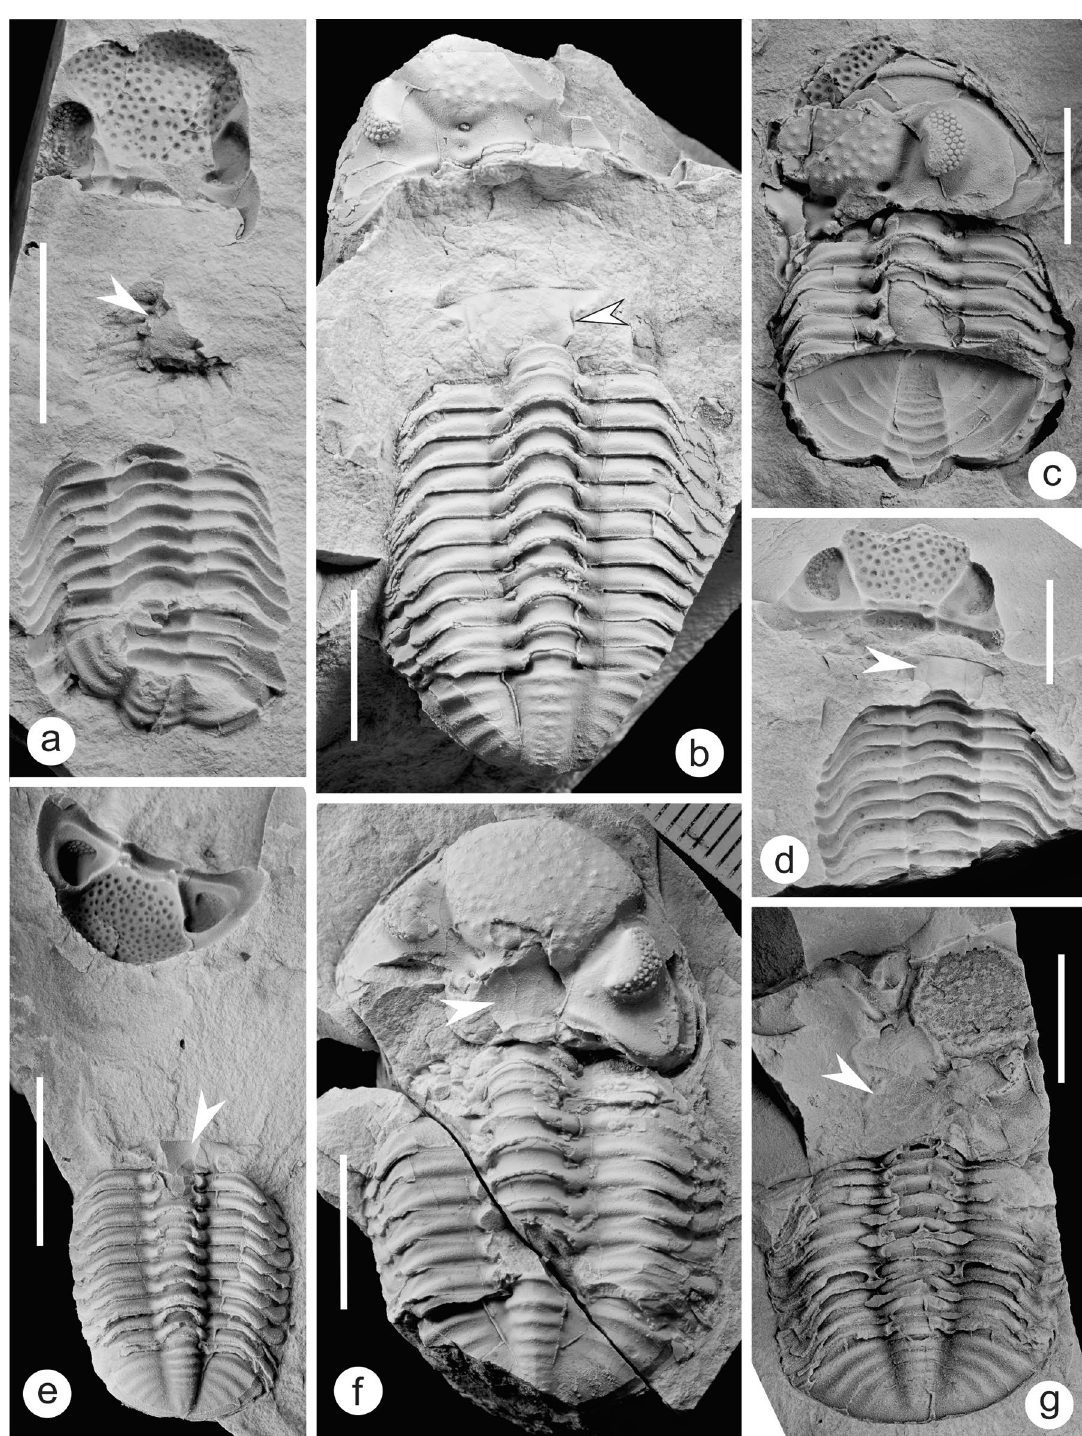
Figure 2. Different types of exuviae of Omegops sp. A from the middle part of the MHF in western Junggar. ( a ) Enrolled thoracopygon with separated cephalon, external mold (BGEG-WJ18-02). ( b ) Flat extended thoracopygon with separated cephalon (BGEG-WJ18-03). ( c ) Separated cephalon overlapping enrolled thoracopygon (BGEG-WJ18-05). ( d ) Cephalon separated from thorax, pygidium is not preserved, external mold (BGEG-WJ18-01). ( e ) Flat extended thoracopygon, with separated inverted cephalon (BGEG-WJ18-06). ( f ) Cephalon separated from thoracopygon and rotated at a small angle (BGEG-WJ18-04). ( g ) Cephalon separated from thoracopygon and rotated at a large angle (BGEG-WJ-77). Scale bar is 10 mm, white arrows indicate the position of the